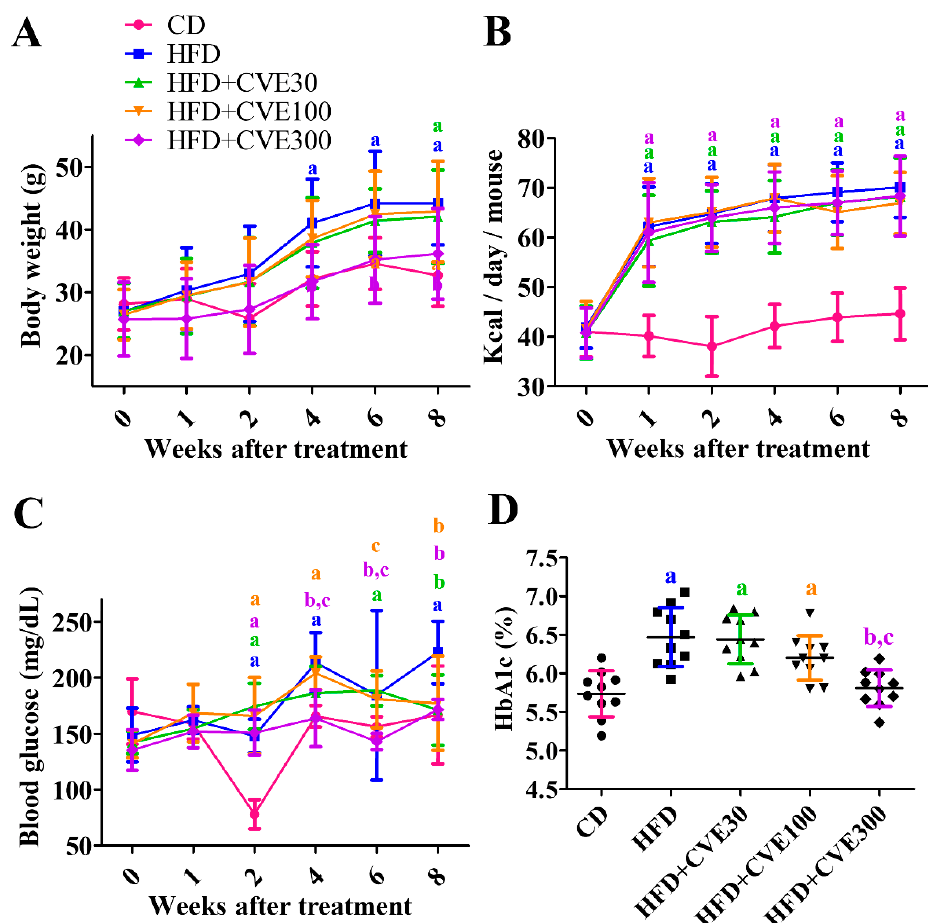
Figure 1. Changes in body weight ( A ), calorie intake ( B ), and blood glucose levels ( C ) during experiments as well as HbA1c levels 8 weeks after treatment ( D ) in the control diet ( CD ) and high fat diet-fed mice with the vehicle, or 30, 100, and 300 mg/kg C. verticillate L. extracts (HFD, HFD+CVE30, HFD+CVE100, and HFD+CVE300, respectively). The data were analyzed by one-way analysis of variance for HbA1c and two-way analysis of variance for others followed by Bonferroni’s post hoc test ( a p < 0.05, significantly different from the CD group; b p < 0.05, significantly different from the HFD group; c p < 0.05, significantly different from the HFD+CVE30 group). The bars indicate the mean ± standard deviation. CD, control diet; CVE, Cissus verticillata leaf extract; HFD, high-fat diet.